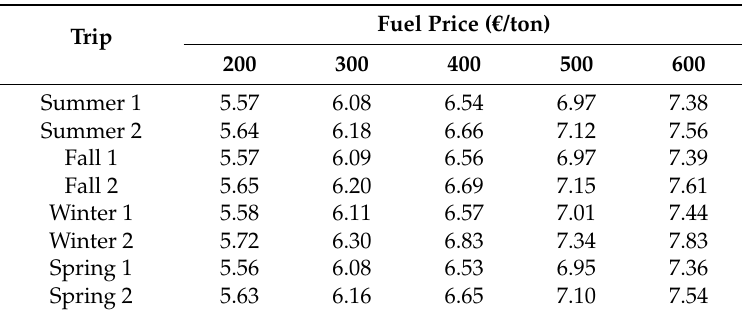
Table 41. Effect of fuel price on the optimal trip durations for double freight rate (numbers in days).